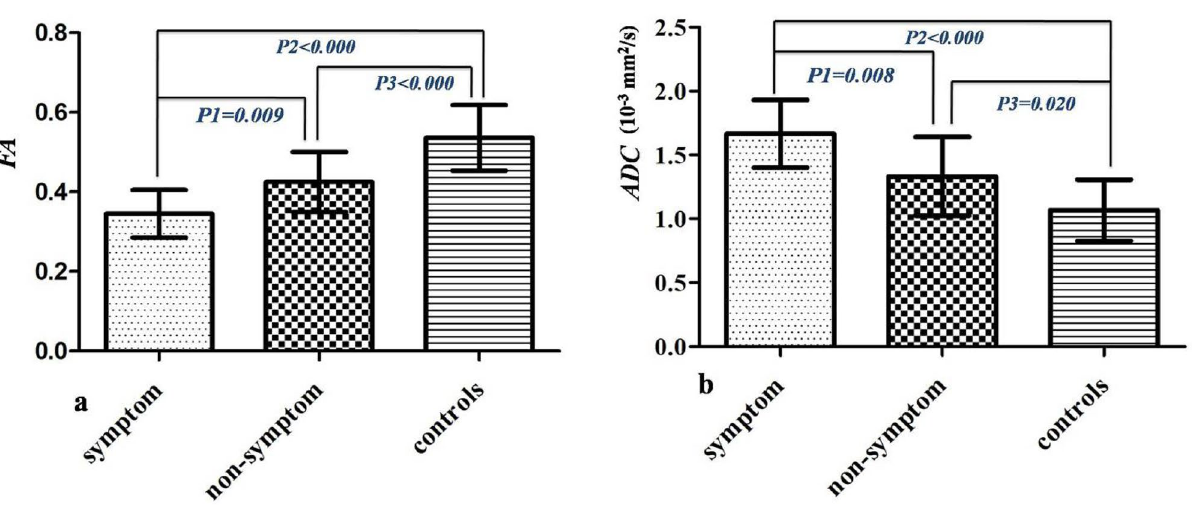
Figure 5. The differences of DTI parameters among patients with clinical symptom, patients without clinical symptom and normal controls. ( a ) The difference of FA values (mean + SD), ( b ) the difference of ADC values (mean +